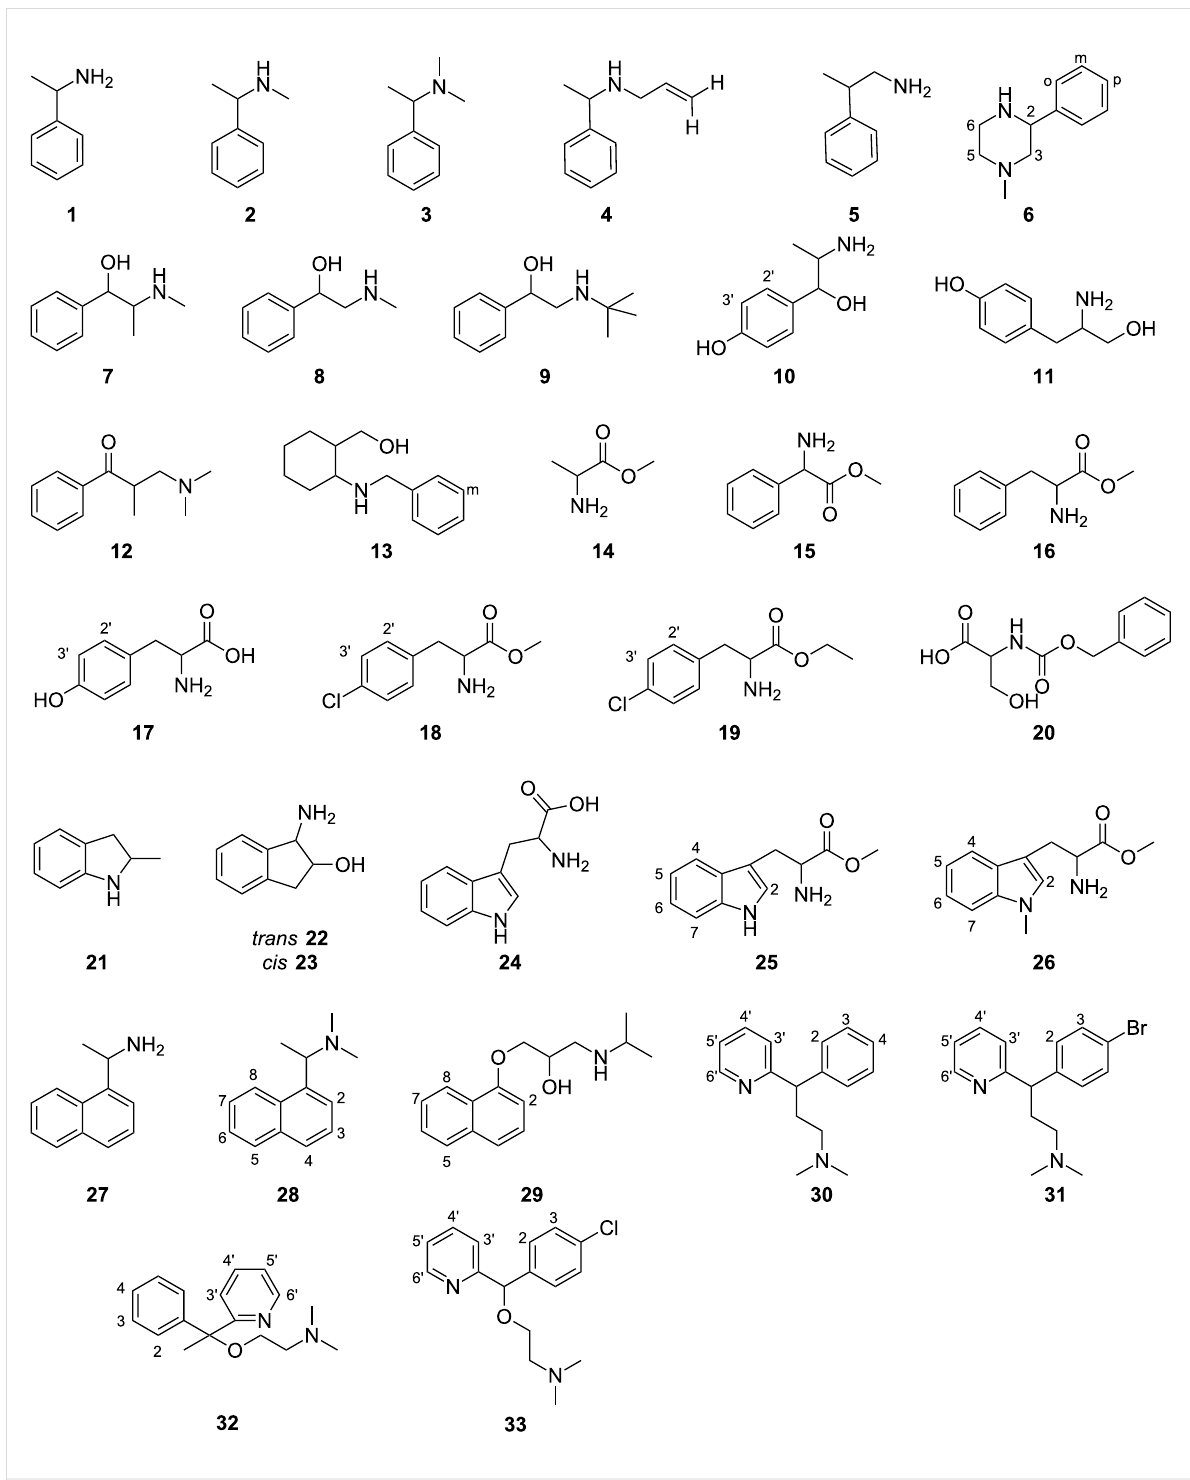
Figure 2: Structures of substrates included in the study. All compounds were examined in their protonated forms with the P-CDs.